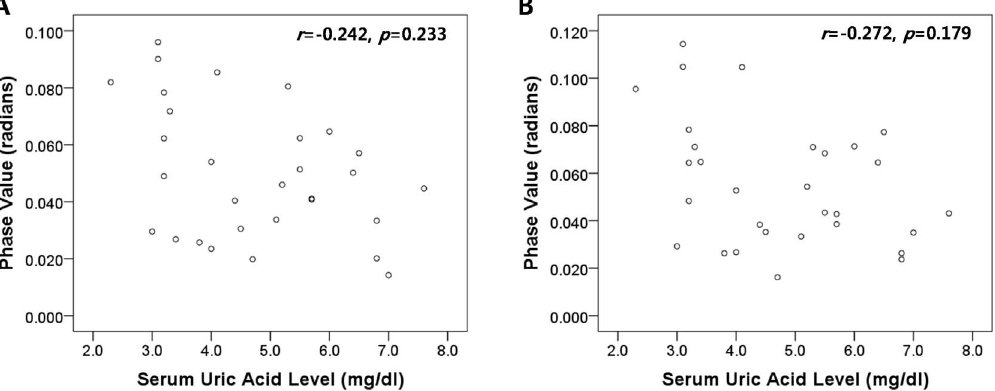
Figure 2. Scatter-plots of phase shift values of substantia nigra (A: bilateral SN, B: SN contralateral to the clinically more affected side) and serum uric acid levels in Parkinson’s disease subjects. The r and p values marked in the figure represent the results of Pearson’s partial correlation analysis adjusting for age, gender, UPDRS III score, and disease duration.